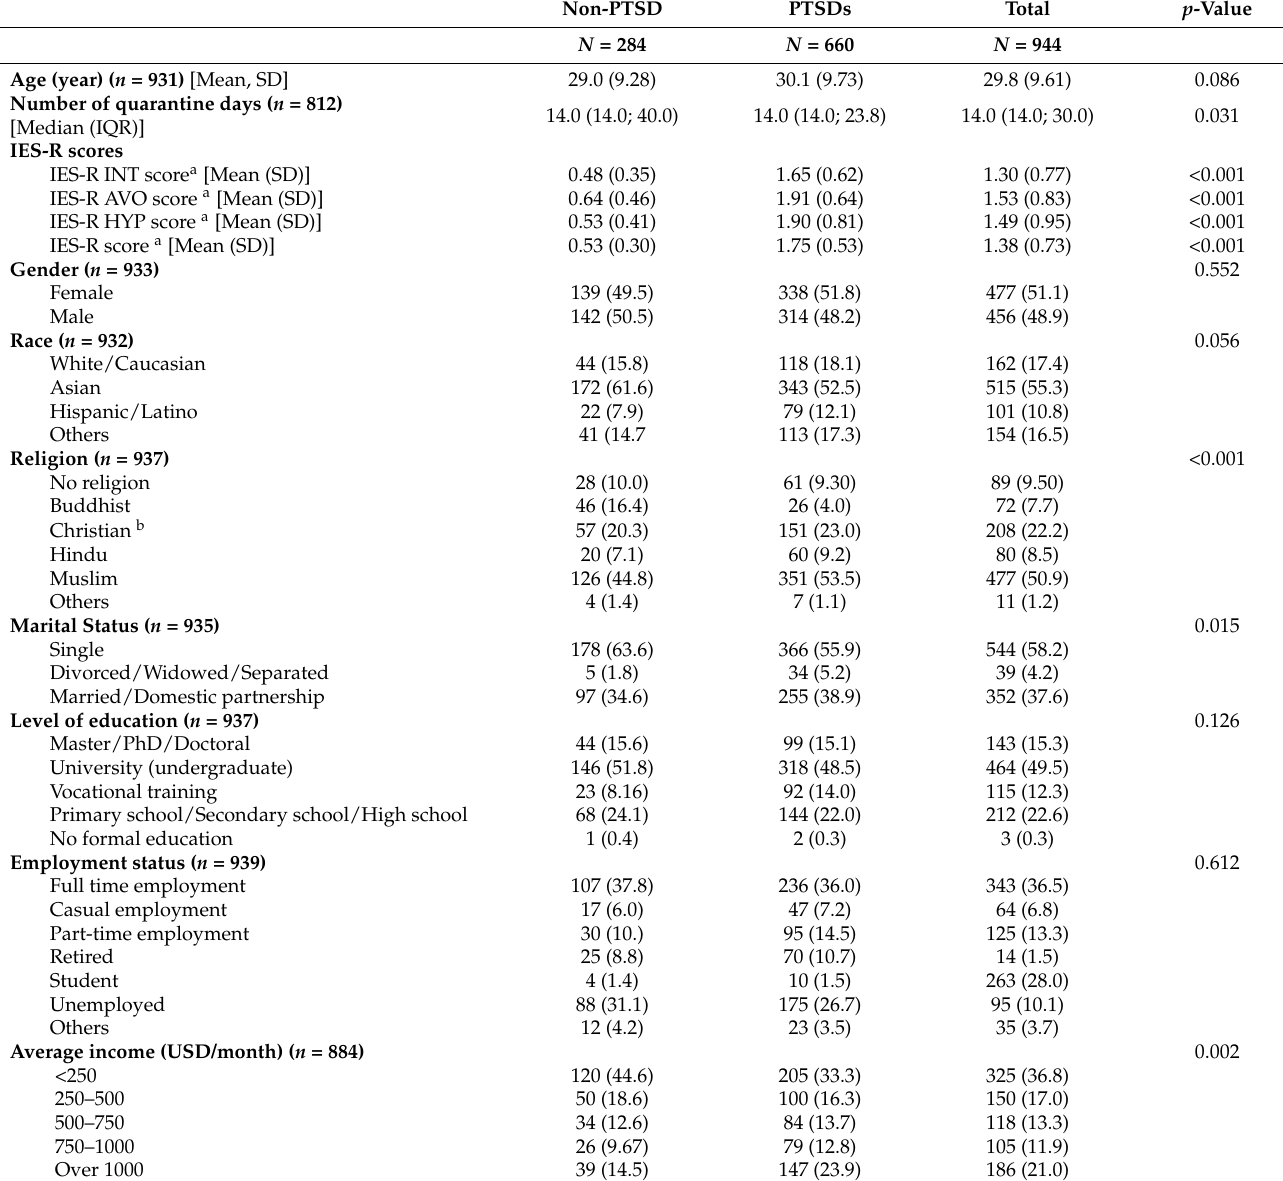
Table 1. Sociodemographic profile of participants and their descriptive summary by non-PTSD and PTSDs groups. Non-PTSD PTSDs